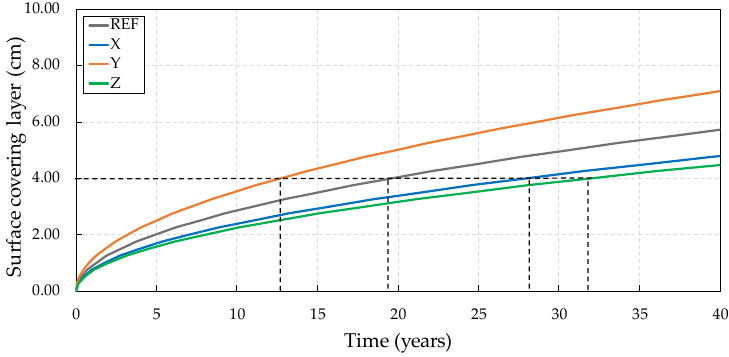
Figure 12. Service life prediction of cracked concretes subjected to two wet–dry cycles.